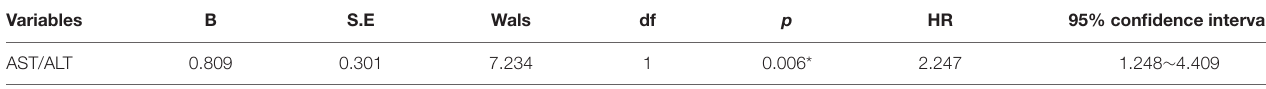
TABLE 6 | The results of logistics regression analysis (7-years follow up). Variables B S.E